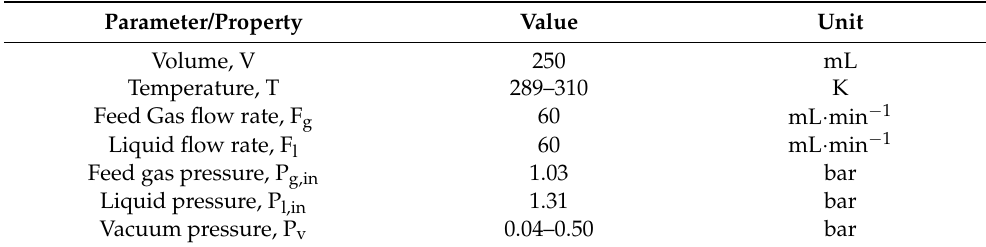
Figure 3. Experimental setup of the CO 2 absorption–desorption process with one absorption HFMC and one desorption HFMC for MVR. Gas flow (dashed lines), Liquid flow (solid lines). Table 3. Operating conditions of the absorption–desorption process based on the non-dispersive gas–liquid HFMC contactors, laboratory